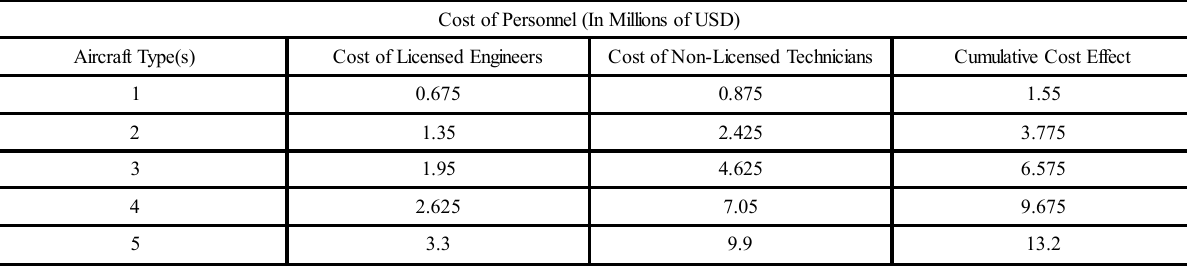
FIG. 6. PERSON-POWER RELATIONSHIP VS AIRCRAFT FIG. 7. COST OF PERSONNEL RELATIONSHIP VS AIRCRAFT TYPES IN REVISED MODEL (WITH ENLARGED SCALE) TYPES IN REVISED MODEL TABLE 4. COST OF PERSONNEL IN REVISED